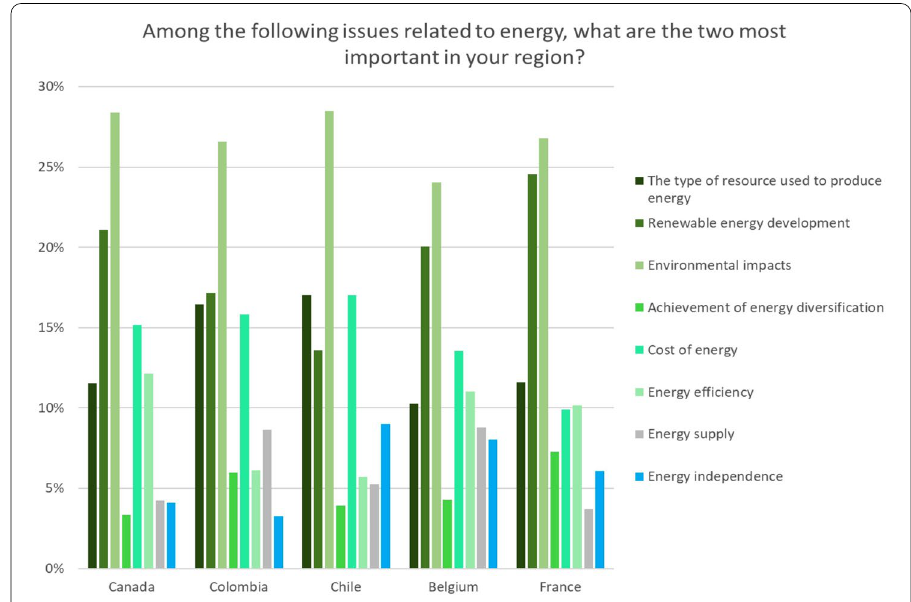
Fig. 1 Description of main issues related with energy